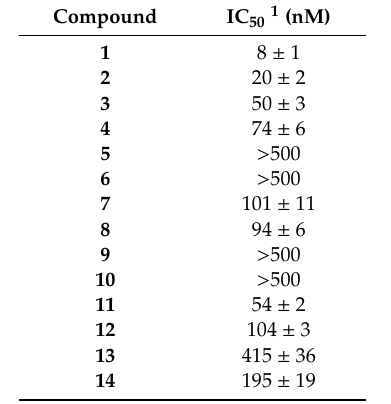
Table 1. Cytotoxic activity of core-extended naphthalene diimides (c-exNDIs) in A375 melanoma